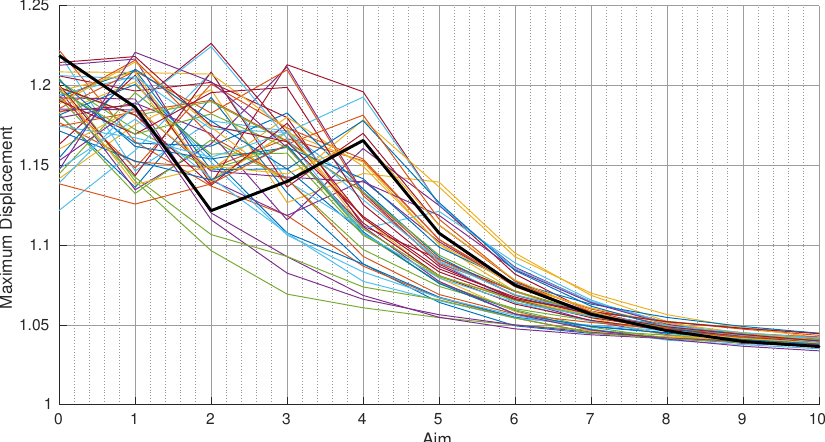
Figure 5. Maximum vibration amplitude for increasing intentional mistuning amplitude for 50 random mistuning patterns. Rotor A, alternate pattern, ξ = 10 − 2